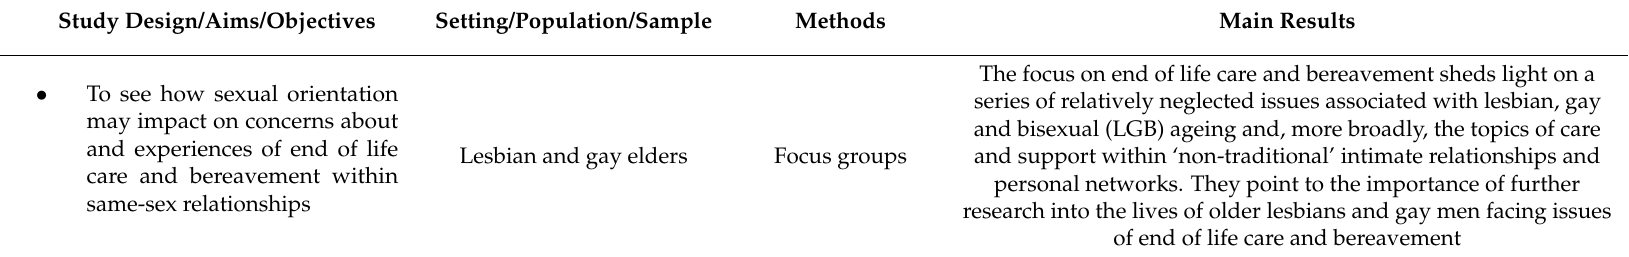
Table A3. Palliative UK LGBT+